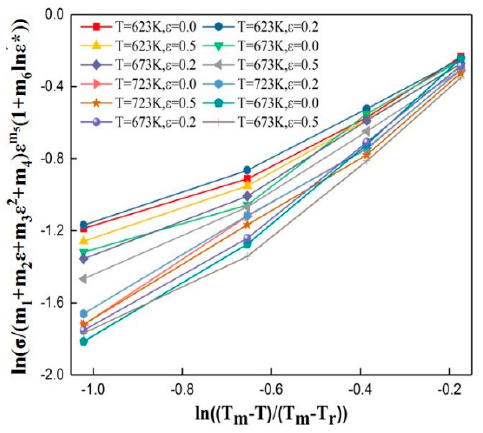
(cid:0) m 1 + m 2 ε + m 3 ε 2 + m 4 ε m 5